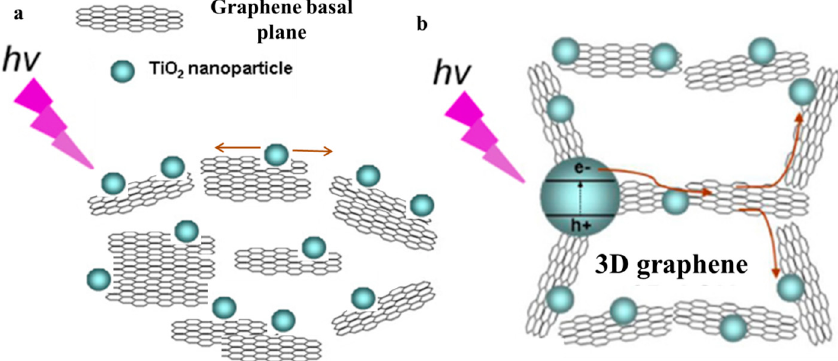
Figure 14. Schematic diagram of electron transport in the ( a ) 2D graphene-TiO 2 composite and ( b ) 3D graphene-TiO 2 composite. Reproduced with permission from [111]. Copyright ACS,